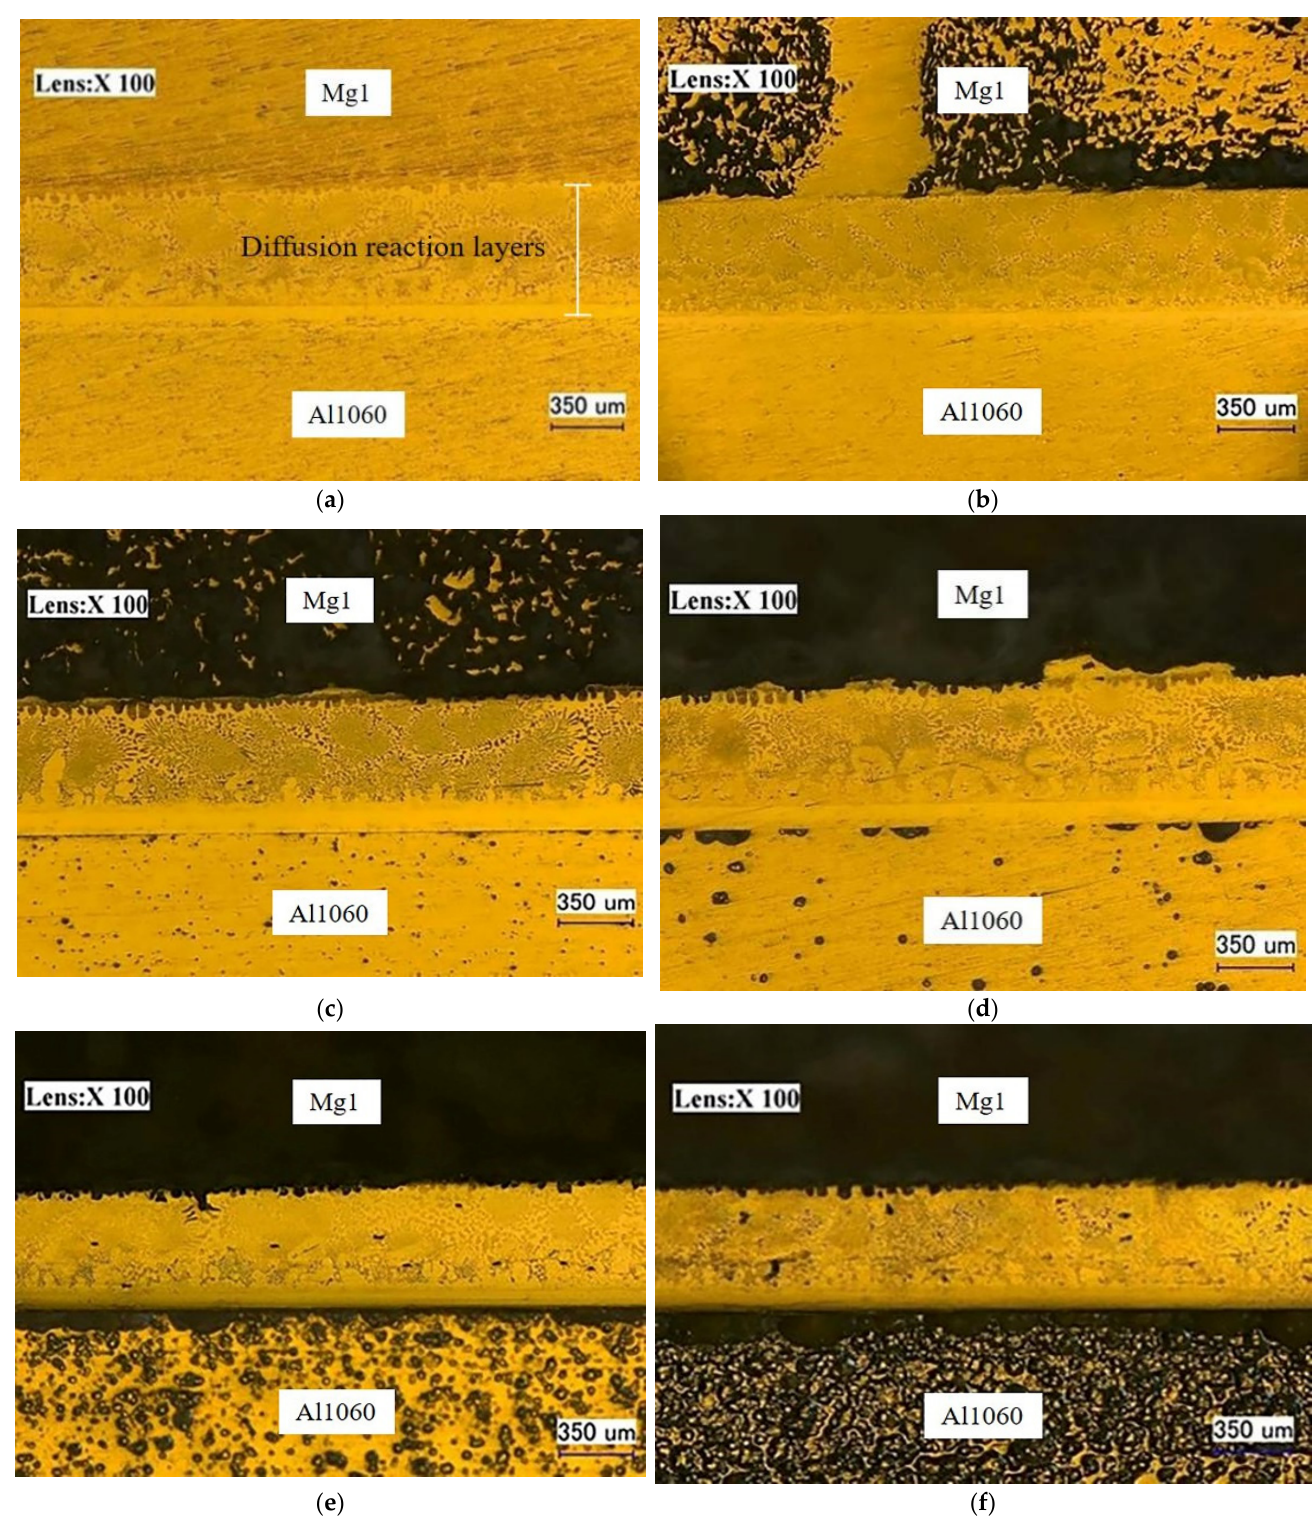
Figure 4. Surface morphology of the substrates and diffusion layers for different immersion